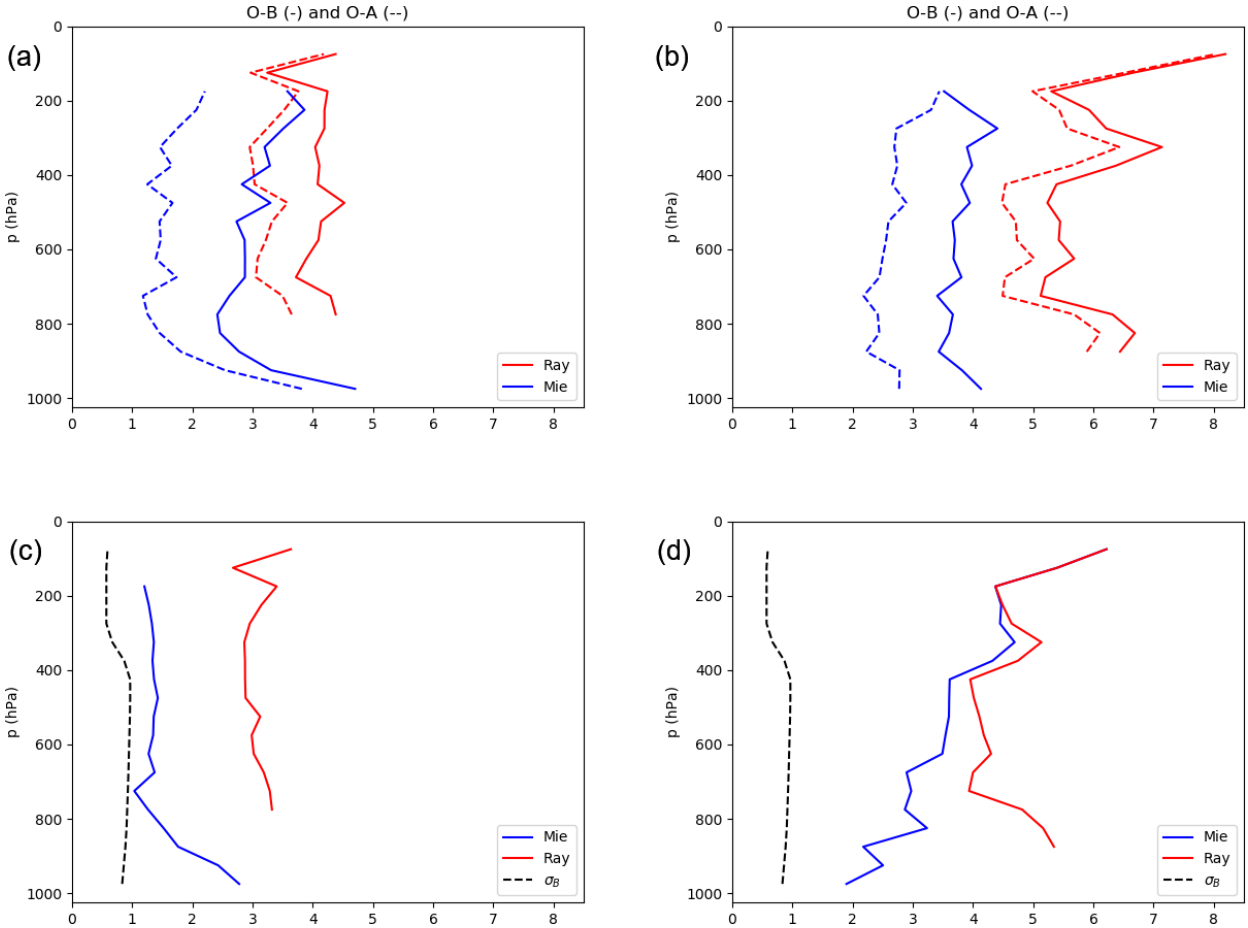
Figure 4. Standard deviations of O − B (solid lines) and O − A (dashed lines) departures for Mie (blue) and Rayleigh (red) observations during the laser A period (a) and laser B period (b) . The mean observation errors for the same data are shown in the lower half of the figure, together with the background error (black dashed lines).